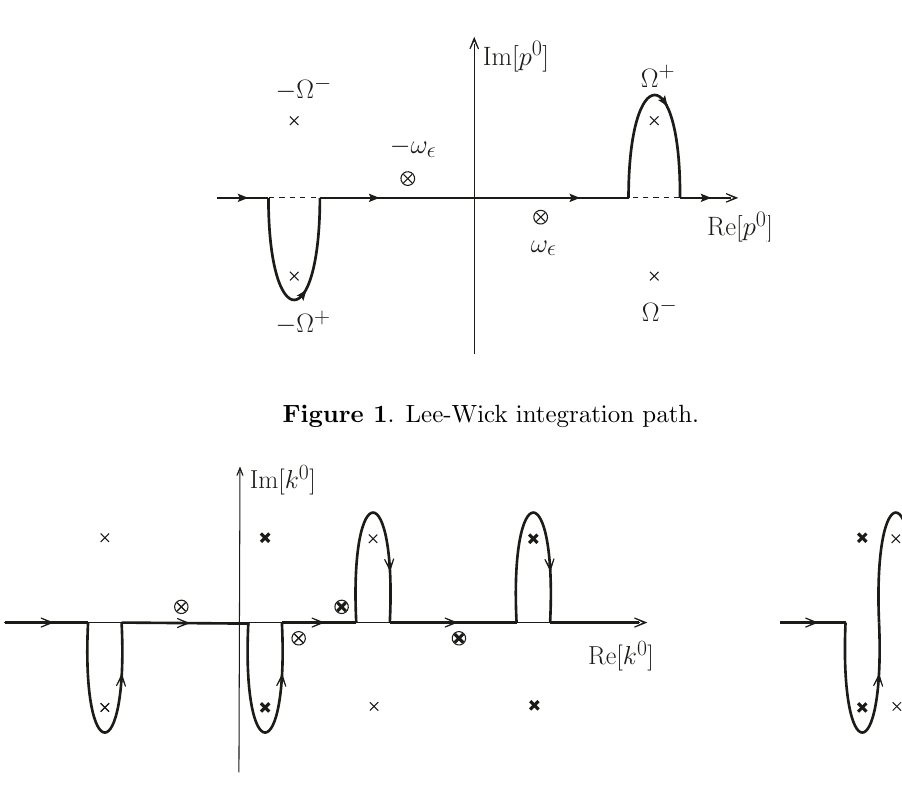
Figure 2 . Lee-Wick integration path for the bubble diagram (left) and LW pinching (right). not equivalent, since the free propagators have poles in the (cid:12)rst and third quadrants of the complex